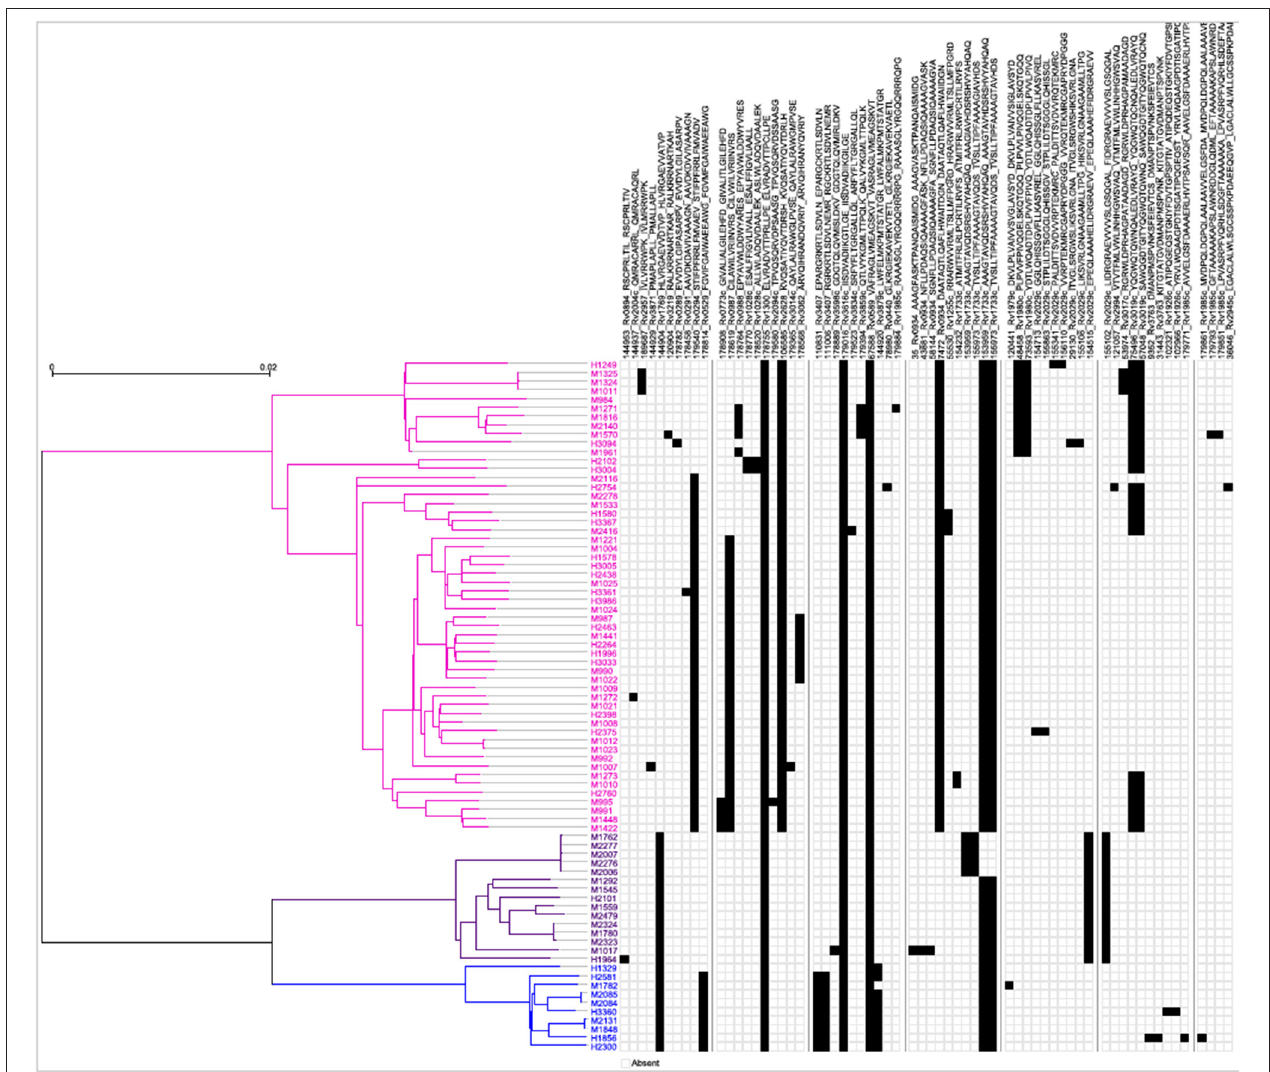
FIGURE 2 | Schematic representation of the phylogenetic relationship of mTCEs of all 79 Mtb strains. Maximum Likelihood tree shows the phylogenetic relationship of the 79 strains studied, based on SNP data. The phylogeny shows two major clades, one consisting of 54 EAI lineage strains (pink), and another one consisting of two clusters, including 10 Beijing/BEI (blue) and 15 CAS (purple) lineage strains, following the naming convention in Comas et al. (13). Each of the columns represents one of the 64 mutated T-cell epitopes. The presence of a mutation in a particular strain is represented by a black